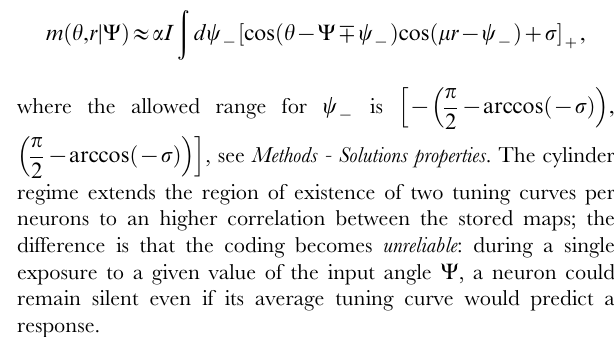
Figure 5. Network representations in the cylinder regime. A: MF time-course of y A , B , when a moving input localized around Y t ð Þ ~ either map A or B , is fed to the network. The location of the maximum of the external input in the stimulated map is shown with a dashed blue line. The order parameter y A , B tracks the external input with a delay. B: The order parameter y { , giving the position of the bump in r , with the same moving inputs. Depending on the stimulated map, the bump ends up in different positions, orthogonalizing the representations. Noisy curves from a simulation including a zero average white noise term in the external input, with s : d : ~ N I . C: A snapshot of the network activity at a given time t and corresponding angle Y t ð Þ , when the stimulated map is A , left or B , right. Neurons with r values differing enough from 0 (depending on the size of the bump) will exhibit tuning curves only when stimulated in one of the two environments (above/below red dashed lines). The parameters for all the panels are J 1 ~ 35, J 0 ~{ 30, m ~ 0 : 8, ~ 0 : 05 ð Þ .